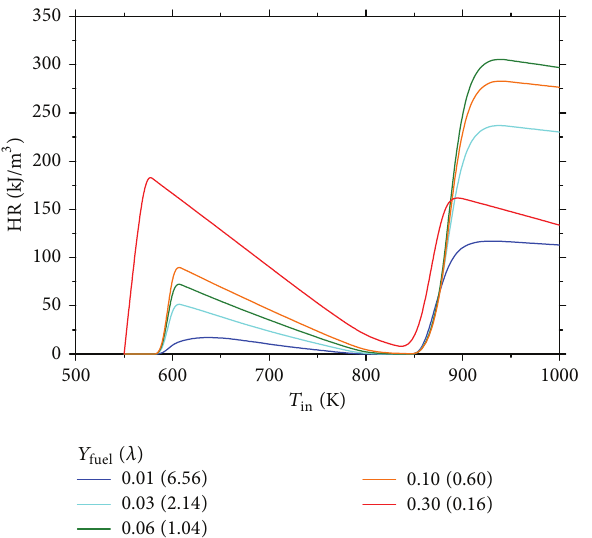
Figure3:Predictionsofheatreleaseperunitvolumeasafunctionof inlettemperaturefor5characteristicvaluesofresidencetime( 𝑌 0.06 ). temperature limit of the respective region, as well as a